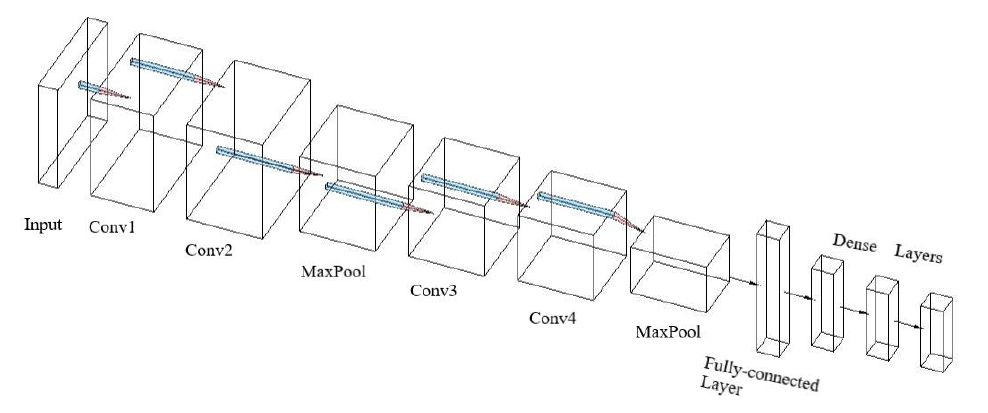
Figure 1. Architecture of proposed CNN